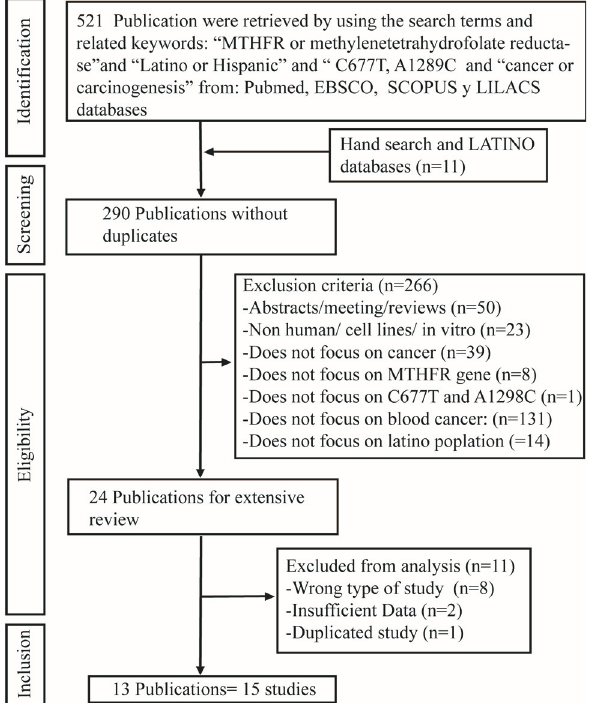
Figure 1 - Flow chart for literature review of studies to be included in the